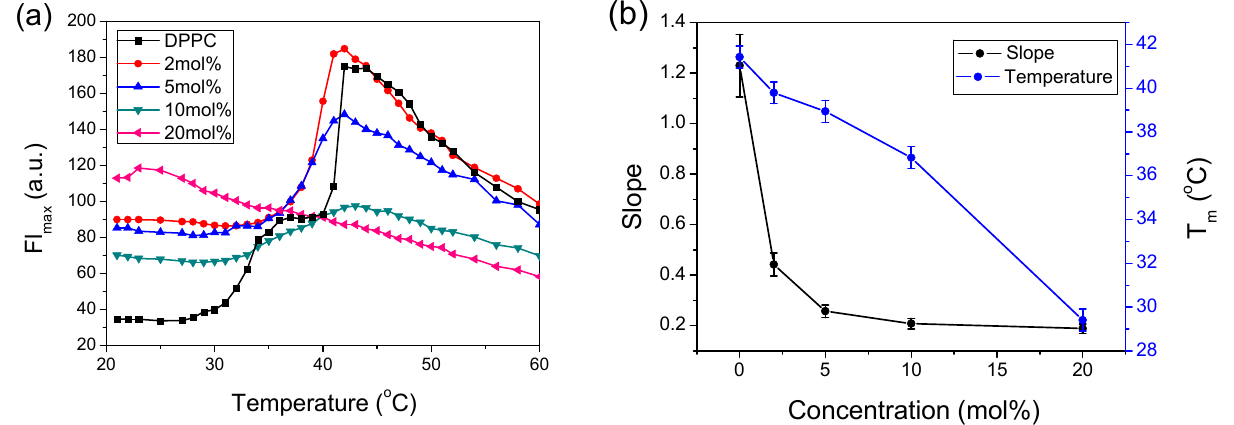
Figure 1. Changes in the ANS fluorescence intensity at the emission maximum (FI max ) versus temperature with the increasing presence of CT in 0.08 mg/mL DPPC: ( a ) during heating from 20 ◦ C to 60 ◦ C; ( b ) plot of fitted parameters to Equation (1) of transition temperature (T m ) and slope obtained during heating versus CT concentrations. ∆ T = 0.5 ◦ C.